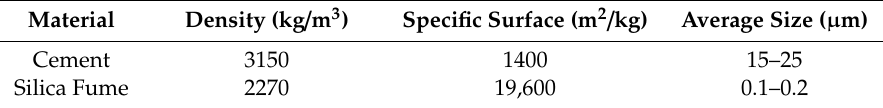
Table 3. Properties of Portland cement and silica